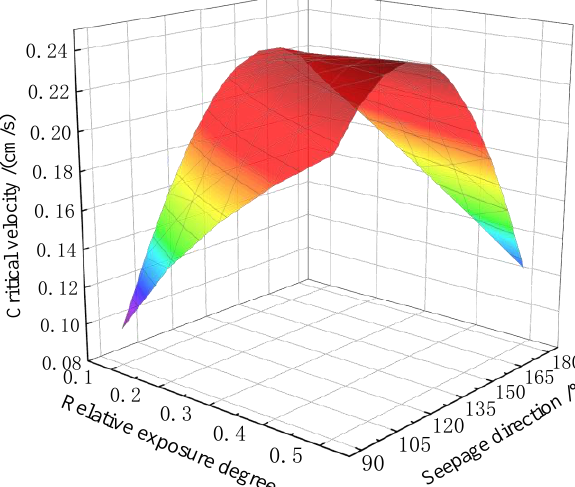
Figure 9. Effect of the relative exposure degree on the critical velocity.